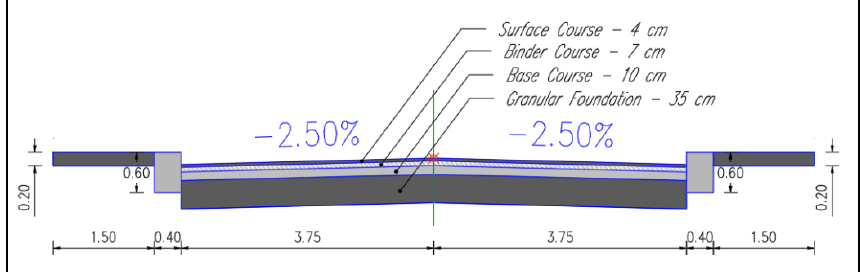
Figure 5. Typological Road section composed of Italian Country Kit subassemblies.